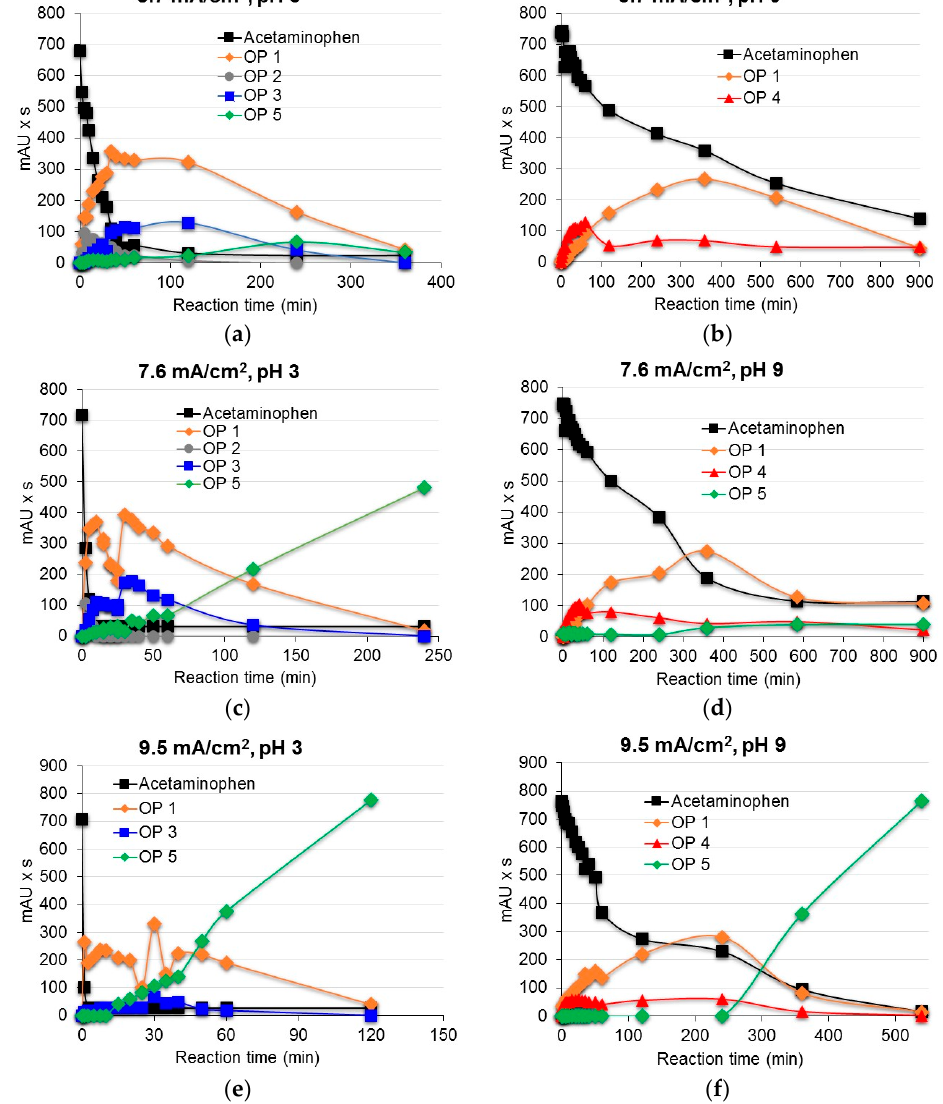
Figure 6. Effect of pH and current density on the degradation of reaction intermediates/oxidation products of acetaminophen. ( a ) 5.7 mA/cm 2 and pH 3; ( b ) 5.7 mA/cm 2 and pH 9; ( c ) 7.6 mA/cm 2 and pH 3; ( d ) 7.6 mA/cm 2 and pH 9; ( e ) 9.5 mA/cm 2 and pH 3; ( f ) 9.5 mA/cm 2 and pH 9.